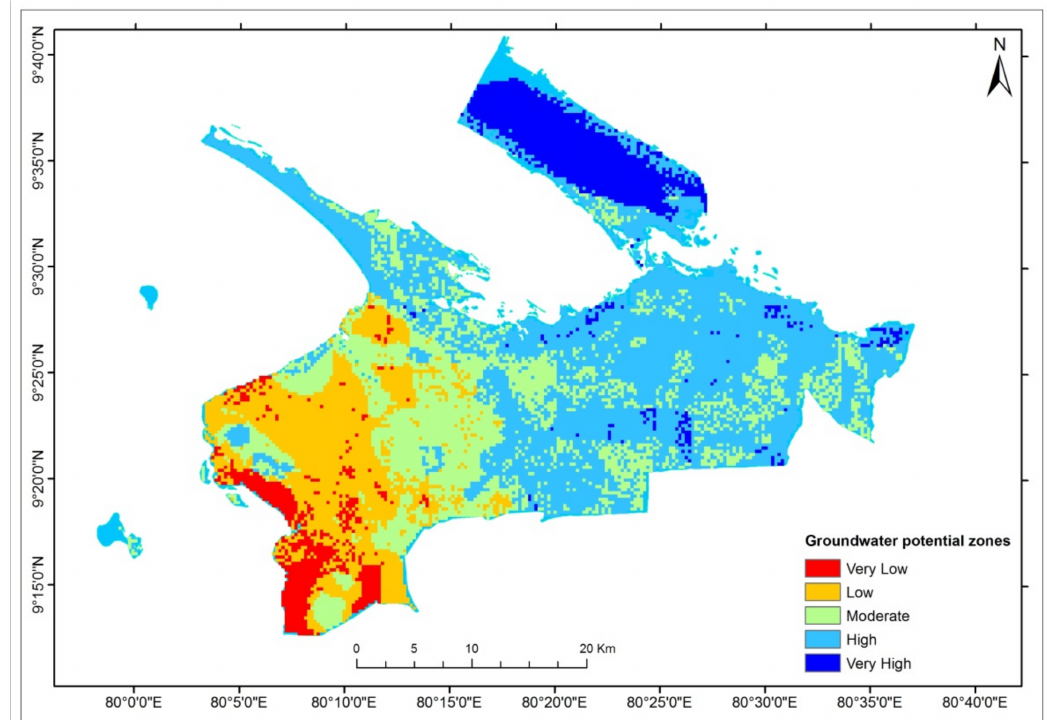
Figure 12. Map of groundwater potential zones of Kilinochchi